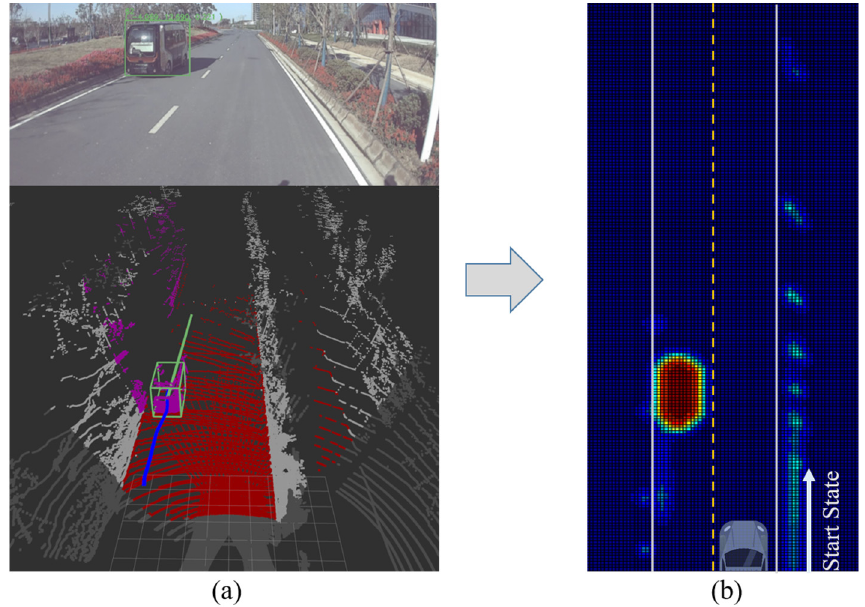
Figure 5. An example of a CR-Map(a, b).